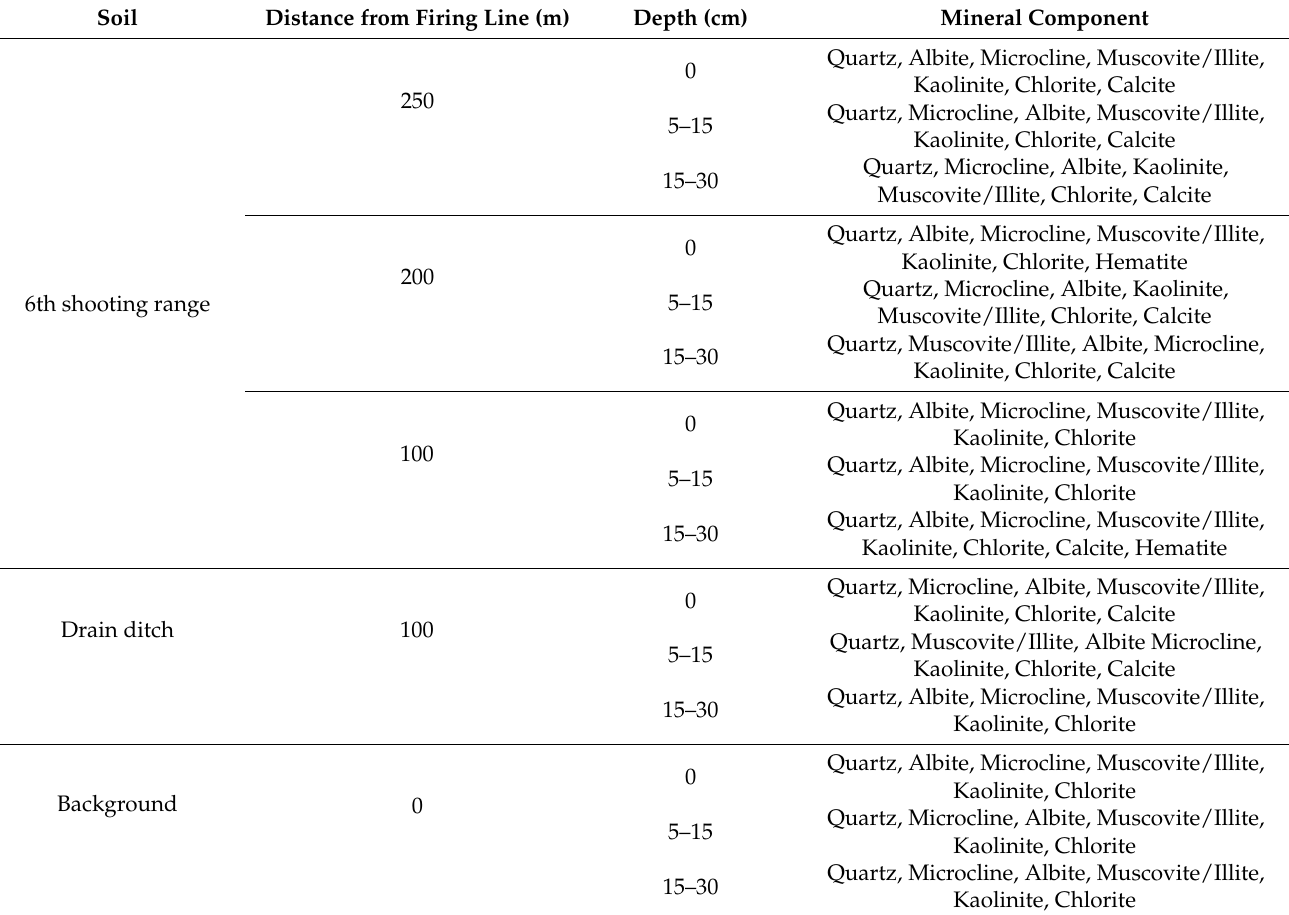
Table 3. The representative mineral components in shooting